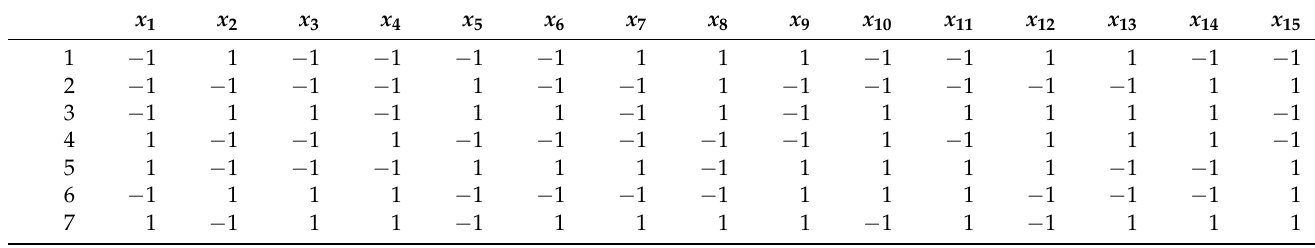
Table 5. E ( s 2 ) -optimal SSD ( 7,15 ) presented in Gutman et al. (2014)